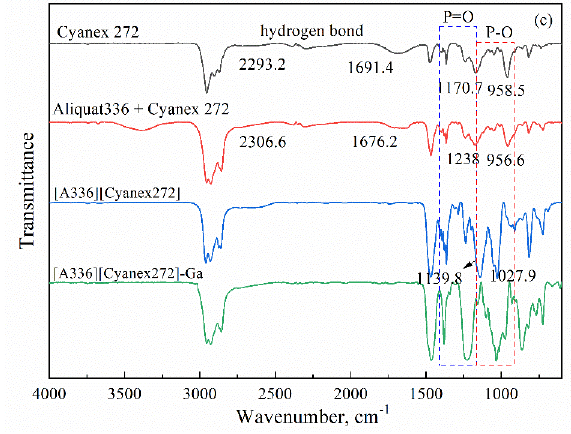
Figure 5. FT-IR spectra of acidic extractants, Aliquat 336, binary mixtures, Bif-ILs and Ga(III)-loaded Bif-ILs. ( a ) D2EHPA based system, ( b ) PC 88A based system, ( c ) Cyanex 272 based system.